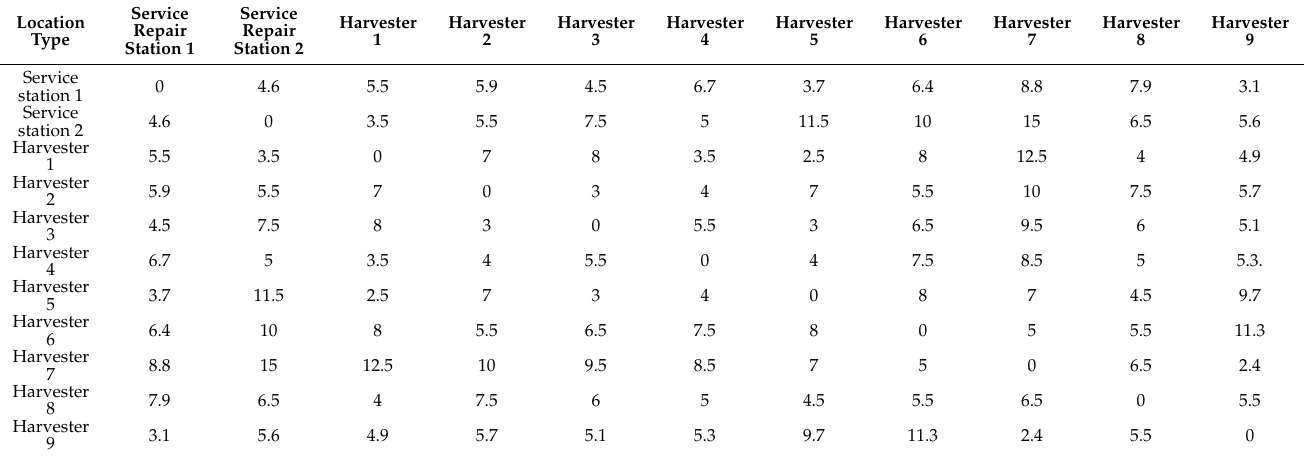
Table 2. Assumed location information of each maintenance service station and the failure point of the harvester.